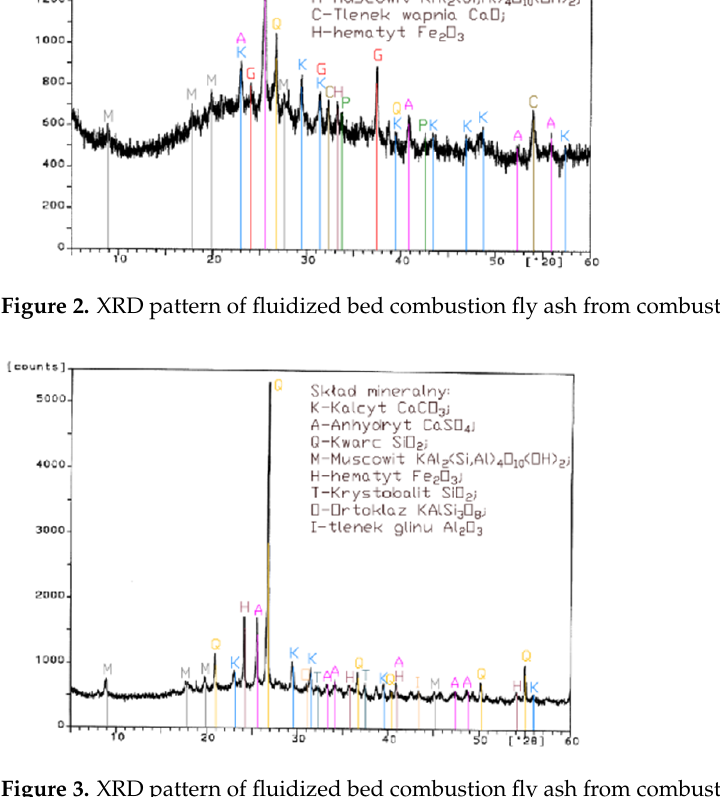
Figure 3. XRD pattern of fluidized bed combustion fly ash from combustion of hard coal (FBC II).